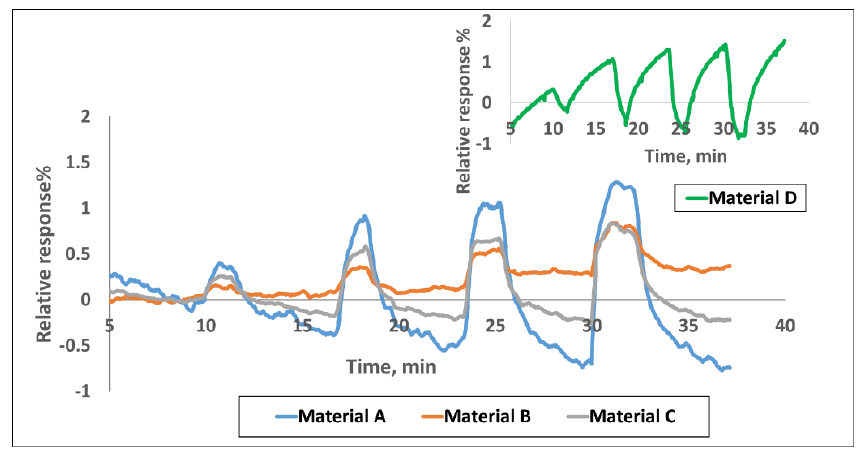
Figure 5. Phone sensor module and its integration with smart phone. The unit on the left contains the sensor chip on PCB and a microfan on the upper left corner. This unit can be attached at the bottom of the phone using the pins. The device can also be configured as a Bluetooth module as well.